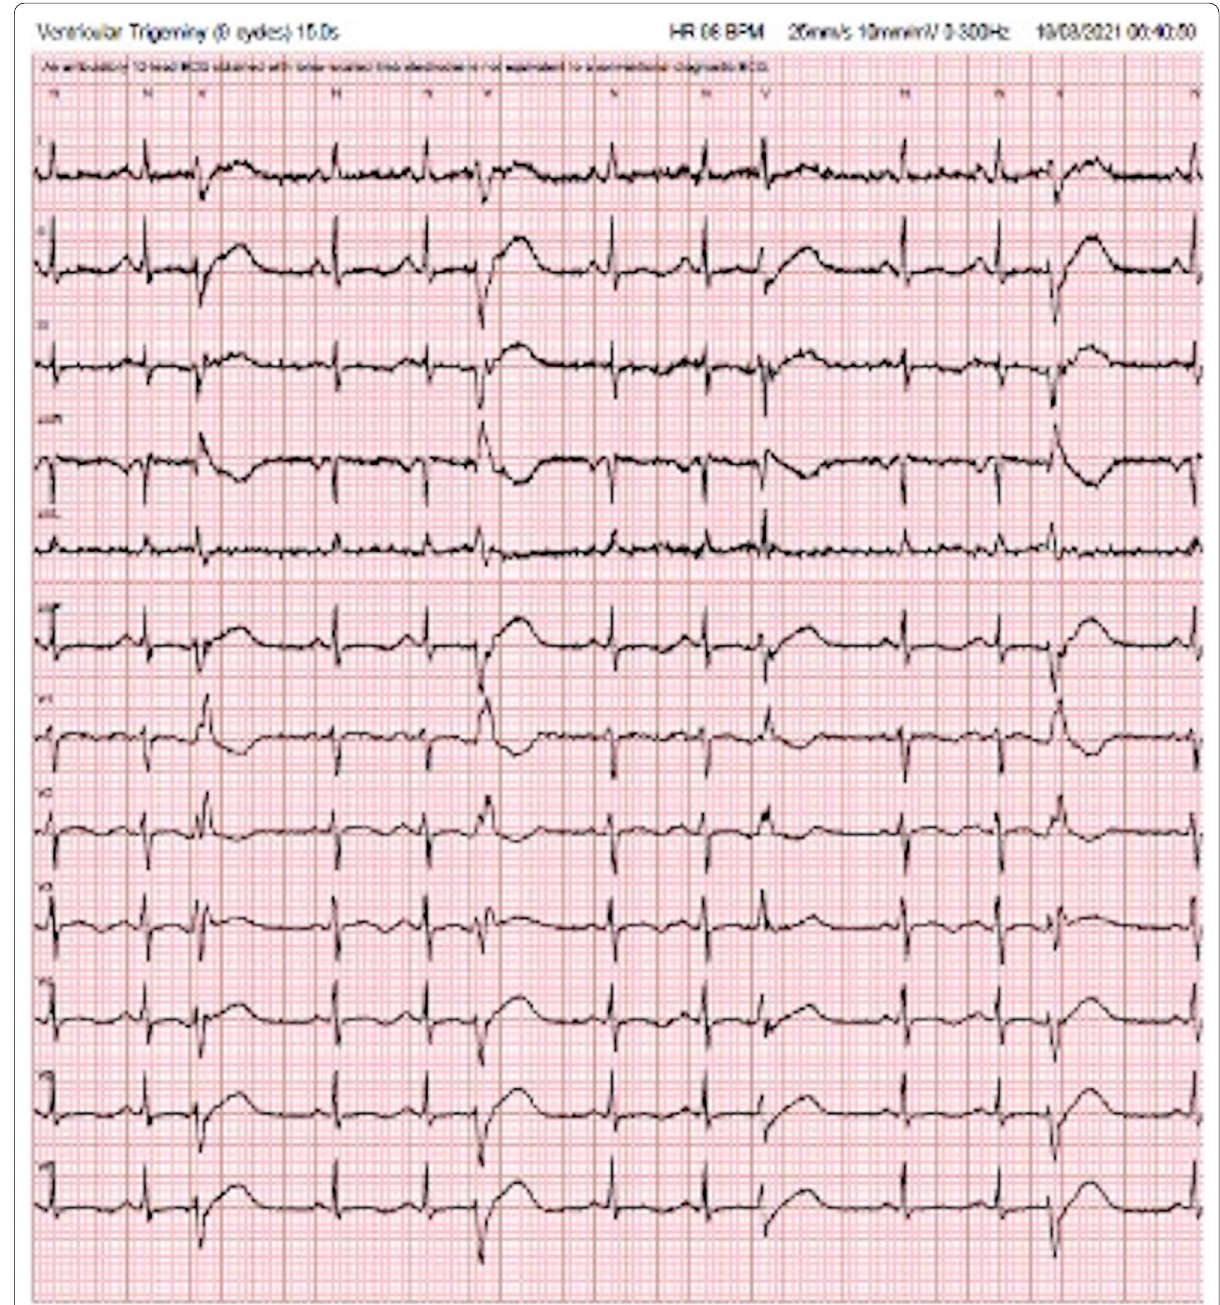
Fig. 3 RBBB with wide QRS displaying the atypical variability, seen most clearly in V1 and V2 with differences seen in each ectopic beat (suggests papillary